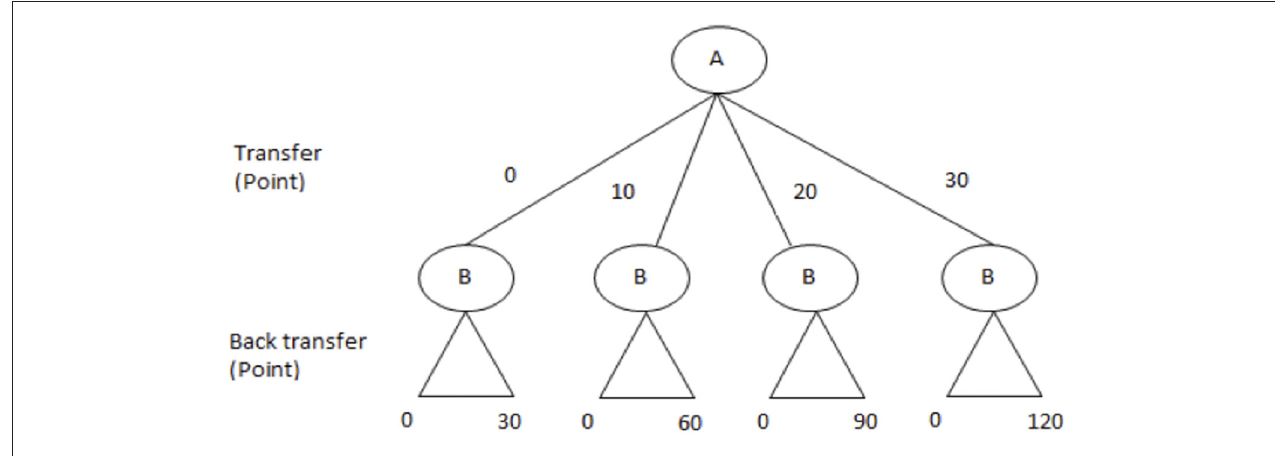
FIGURE 2 | The trust game. There are two players ( A and B ) in this game. Both A and B will receive an initial endowment of 30 points from the experimenter. A can choose whether to send 0, 10, 20, or 30 points to B . Whatever amount A decides to send to B will be tripled by the experimenter before it is passed on to B . B then has the option of returning any amount between zero and his/her total amount of available points to A . For example, if A has sent 10 point, B possesses 60 points (30 points own endowment + 30 points tripled transfer) and can, therefore choose any back transfer from 0 to 60 points. The experimenter does not triple the back